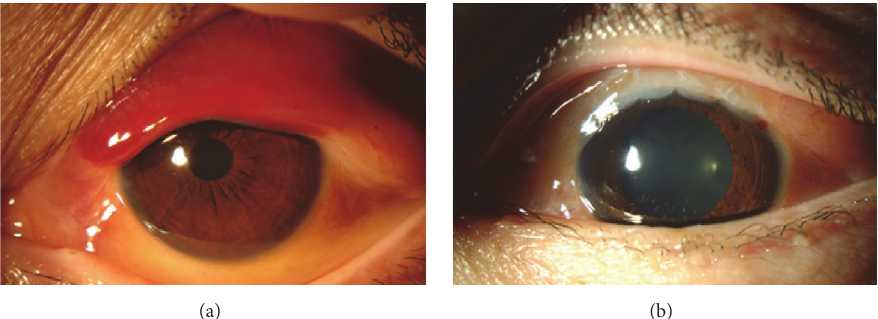
Figure 5: Slit-lamp photographs before and three months after surgery. (b) After surgery, the subconjunctival hemorrhage was not observed. (a) The preoperative subconjunctival hemorrhage can be